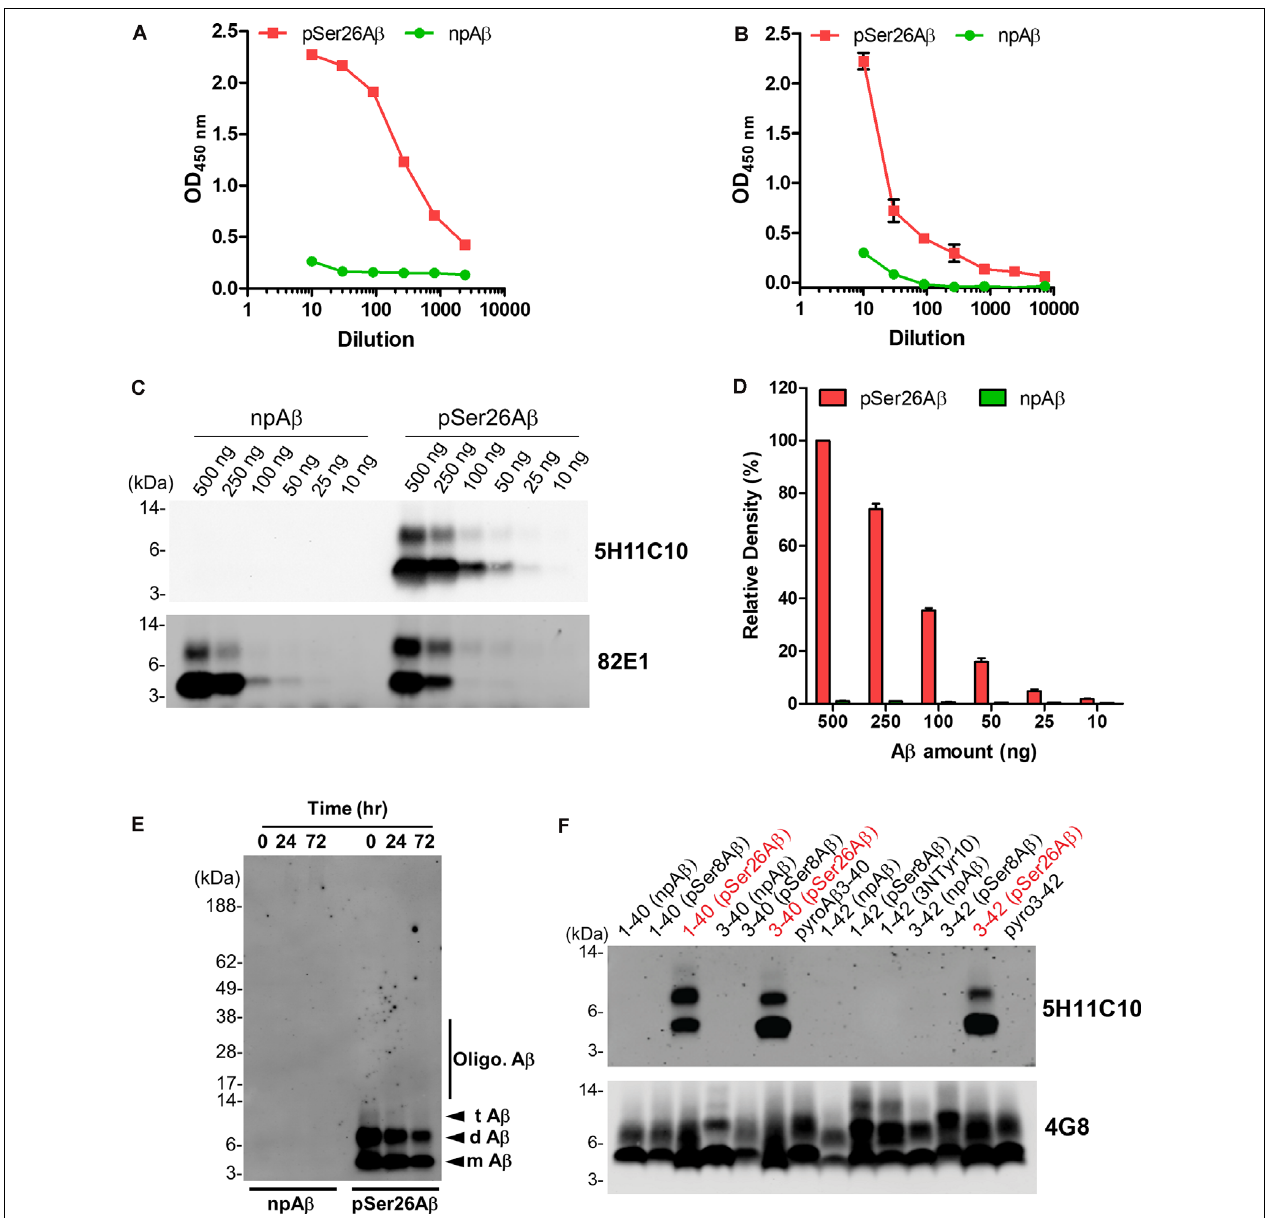
FIGURE 2 | Analysis of pSer26A β mAb 5H11C10. (A,B) Titer determination by indirect ELISA of hybridoma supernatants before (A) and after affinity purification (B) . (C) WB analysis of different amounts of npA β and pSer26A β peptides with 5H11C10 antibody (concentration: 1 µ g/ml) or generic 82E1 antibody. The 5H11C10 antibody selectively recognizes as low as 25 ng of pSer26A β in WB and ELISA ( Supplementary Figures 2A, 3A ). (D) Densitometric quantification of the 5H11C10 antibody reactivity against various quantities of the pSer26A β peptide. Values indicate mean ± SD ( n = 3). (E) Preparations of unaggregated (0 h) and aggregated (24 and 72 h) npA β and pSer26A β peptides were electrophoresed and immunoblotted with 5H11C10 antibody. The 5H11C10 antibody specifically detects pSer26A β in both unaggregated and aggregated state ( Supplementary Figure 4 ). m A β -monomeric A β ; d A β -dimeric A β ; t A β -trimeric A β ; Oligo. A β -Oligomeric A β (F) Variety of non-modified, truncated, and post-translationally modified A β 40 and A β 42 variants were electrophoresed and immunoblotted using 5H11C10 antibody. 5H11C10 antibody specifically detects A β variants phosphorylated at Ser26 (written in red), whereas other modified and non-modified variants are not